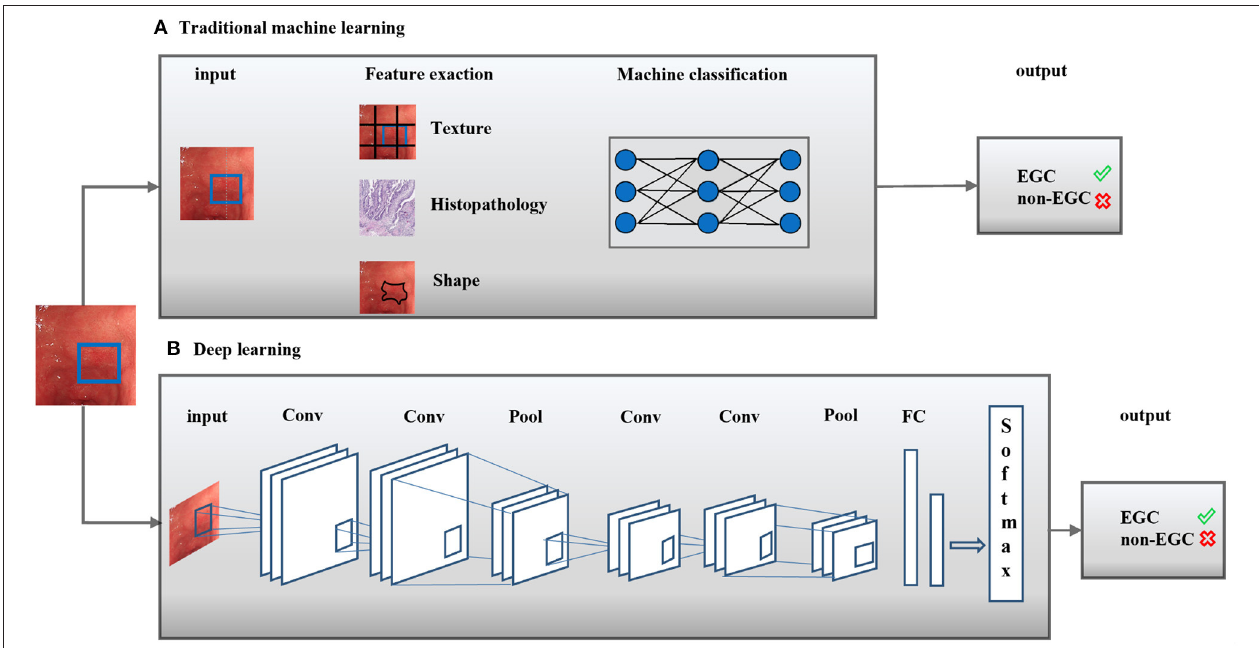
FIGURE 1 | Artificial intelligence methods in medical imaging. Artificial intelligence (AI) methods for a typical classification task were shown. Two classical methods comprise traditional machine learning (A) and deep learning (B) . Conv, Convolutional layer; Pool, Pooling layer; FC, receiver operating characteristic curve; EGC,: Early gastric